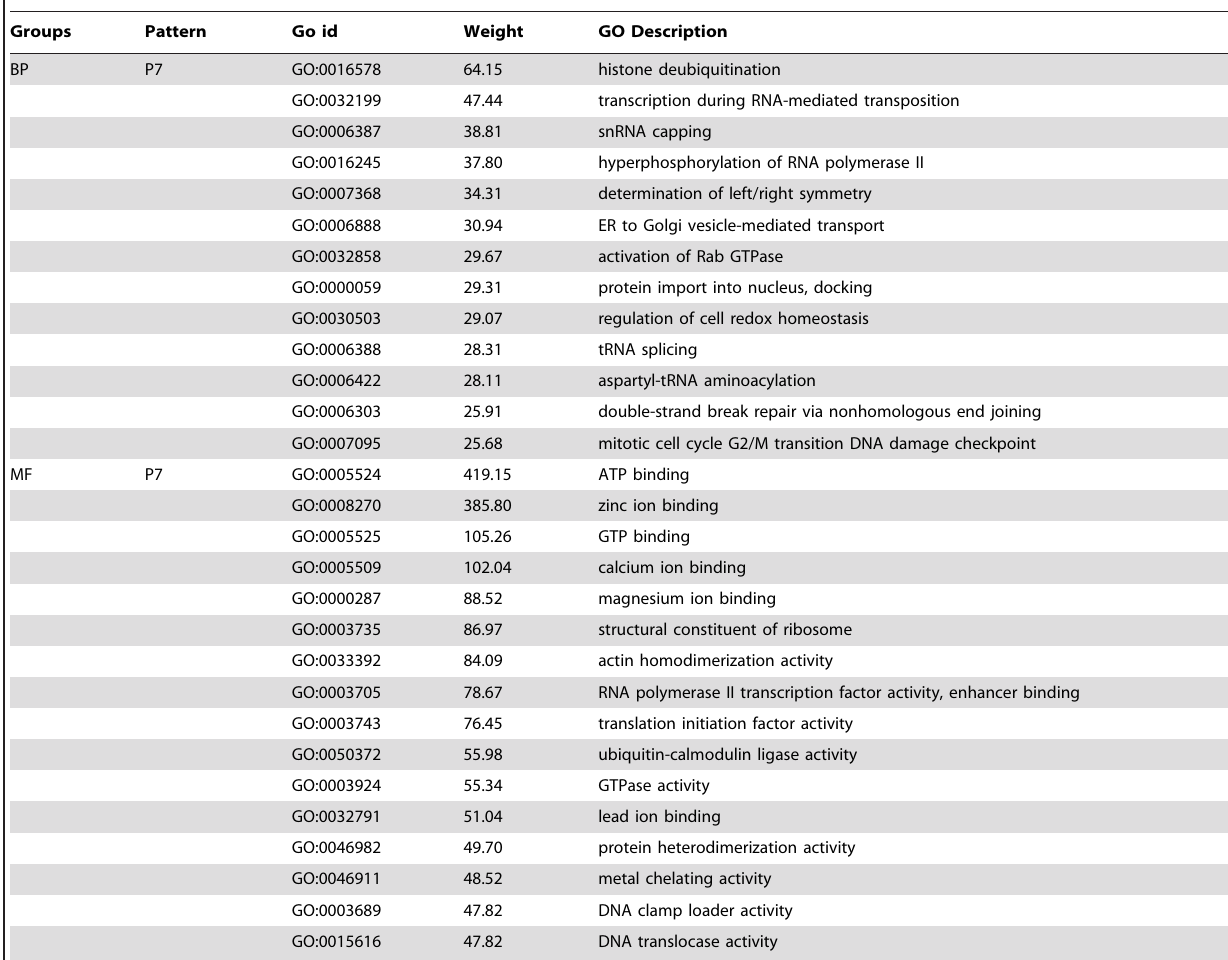
Table 6. Top annotations of the conserved RPG.